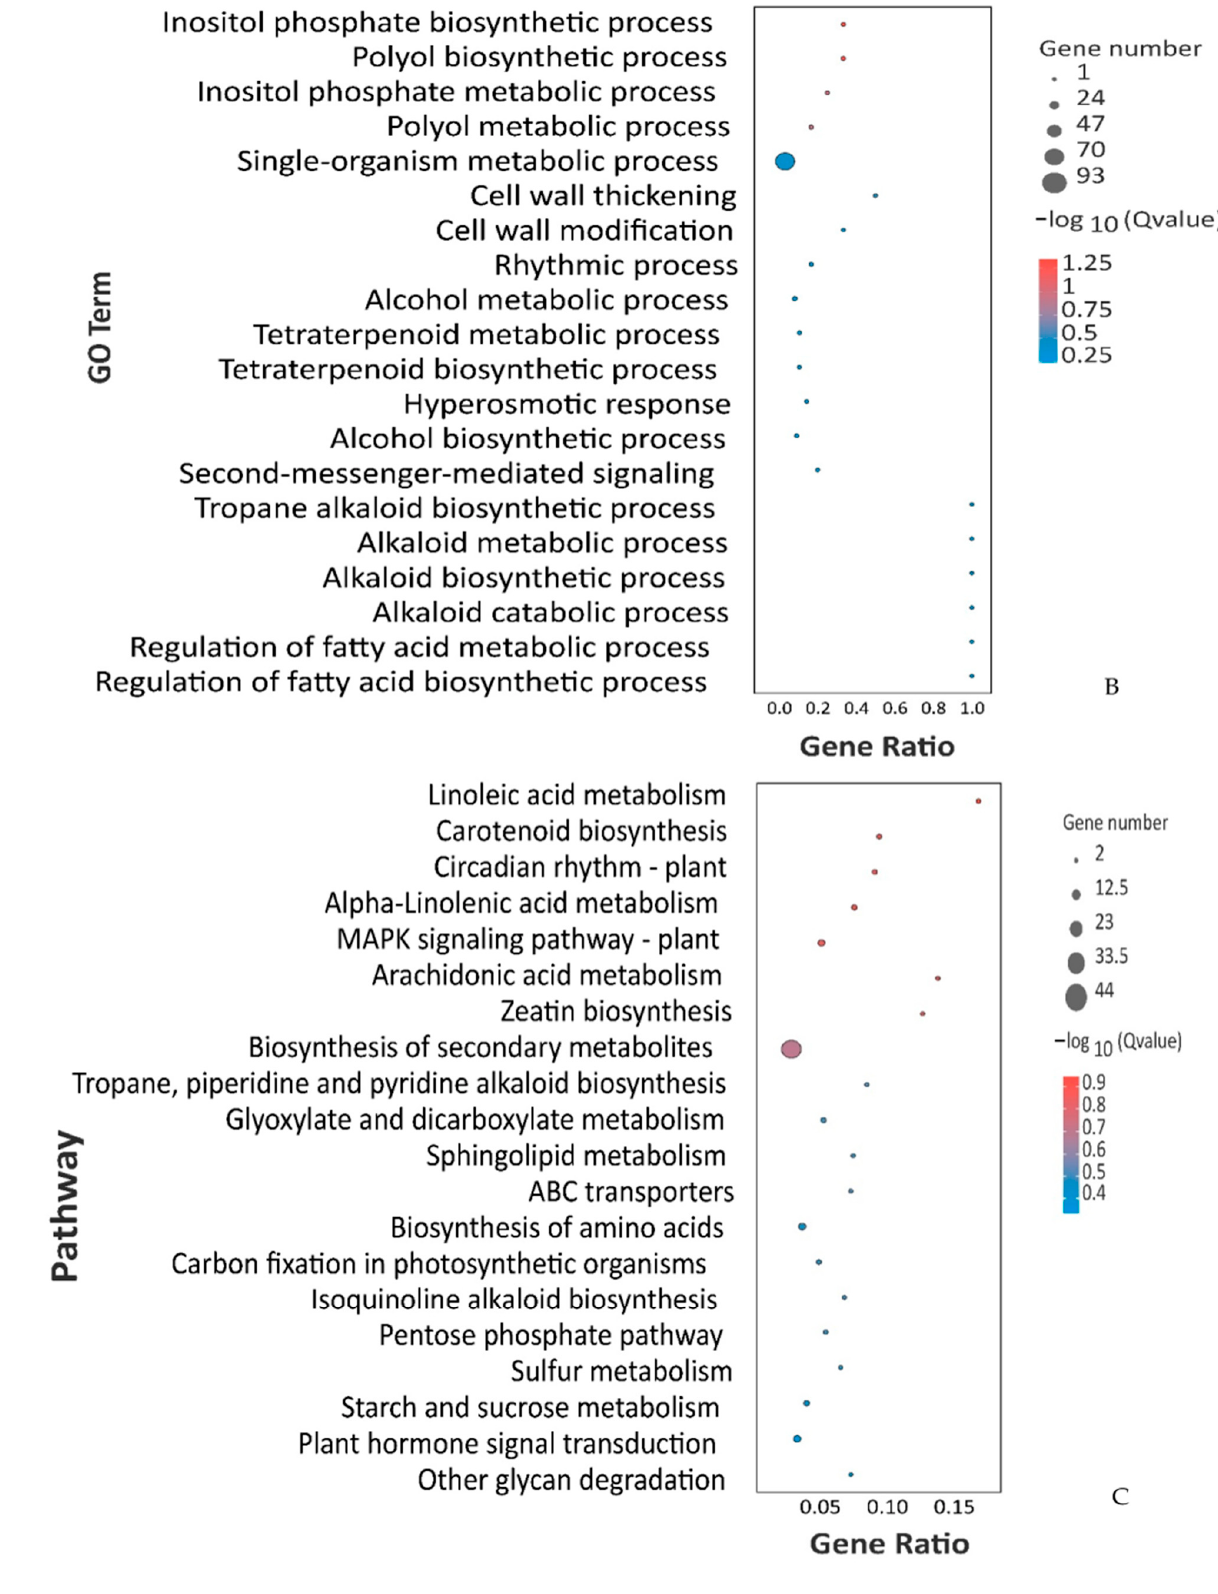
Figure 4. Characteristics of GO and KEGG pathways of differentially expressed genes (DEGs). ( A ) GO annotation, ( B ) and ( C ) GO terms and KEGG pathways (top 20) are both based on false discovery rate (FDR < 0.05).